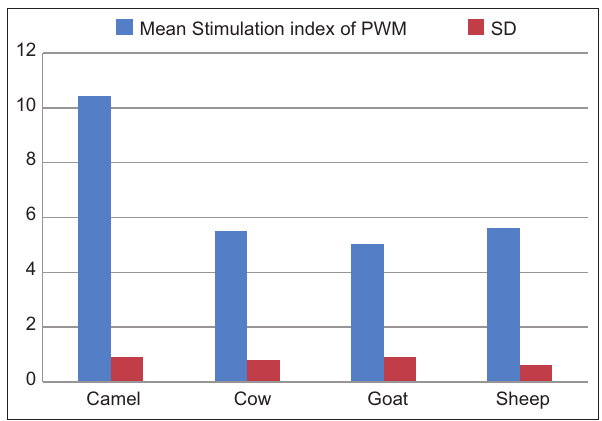
Figure-6: Comparison of stimulation indices of peripheral blood mononuclear leukocytes from camels, goats, sheep, and cows with pokeweed mitogen.